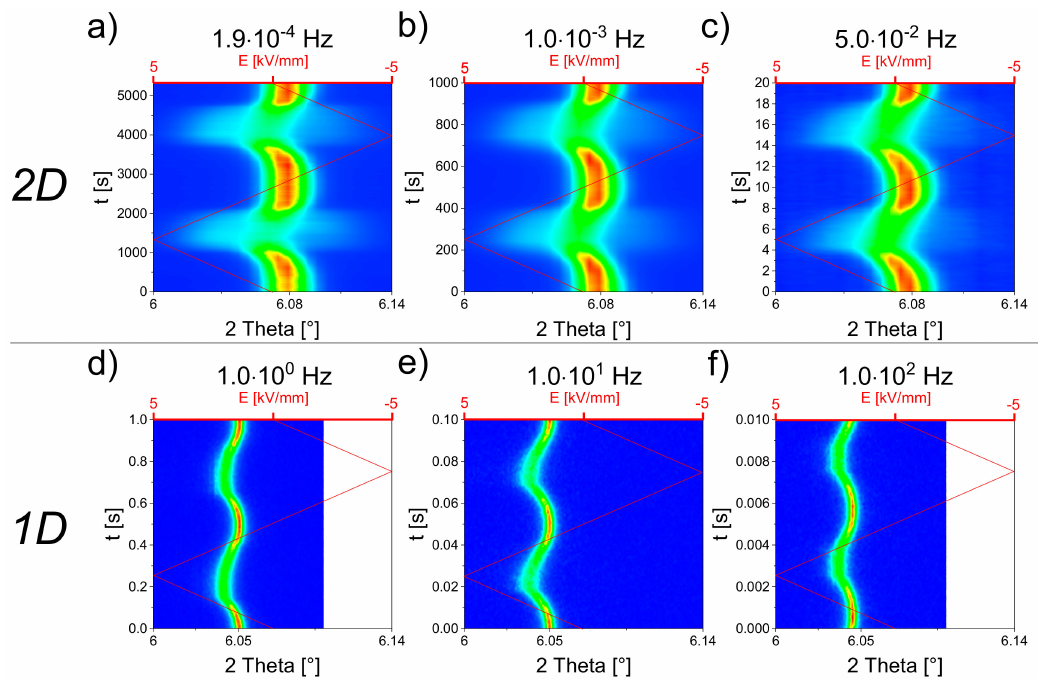
Figure 5. Electric-field-dependent contour plots of the 200 C reflection of BNT–12BT with di ff erent field frequencies. The colors denote intensity values, where red represents the highest intensity. Above ( a – c ): Intensity plots measured at the azimuthal angle 0 ◦ from the 2D detector. Below ( d , e , f ): Intensity plots obtained from the 1D (azimuthal angle 0 ◦ ) high-resolution MAD detector recorded in the stroboscopy mode. No intensity data were collected at the whitened region in ( d ) and ( f